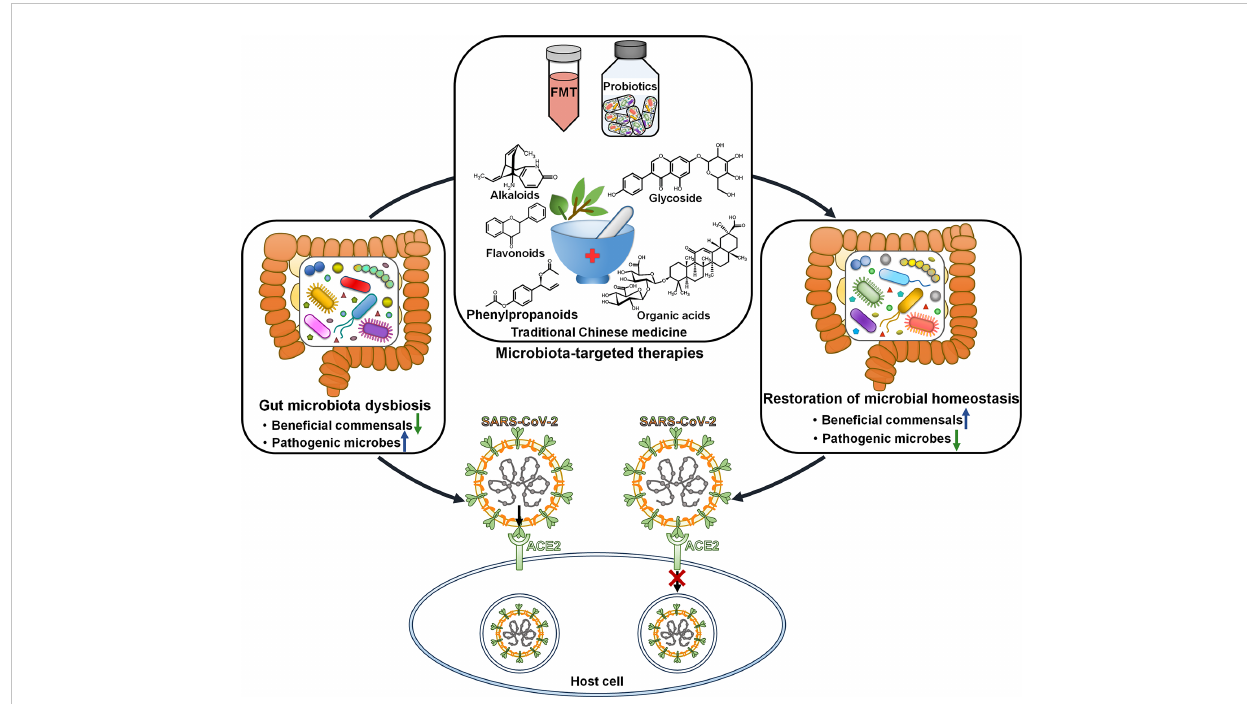
FIGURE 3 Therapeutic potential of microbiota-directed treatments in COVID-19. Microbiota-targeted therapies, including FMT, probiotics and traditional Chinese medicine, may reverse gut microbiota dysbiosis and play a protective role in antagonizing SARS-CoV-2 infection and pathogenesis. FMT, faecal microbiota transplantation; SARS-CoV-2, severe acute respiratory syndrome coronavirus 2; ACE2, angiotensin-converting enzyme